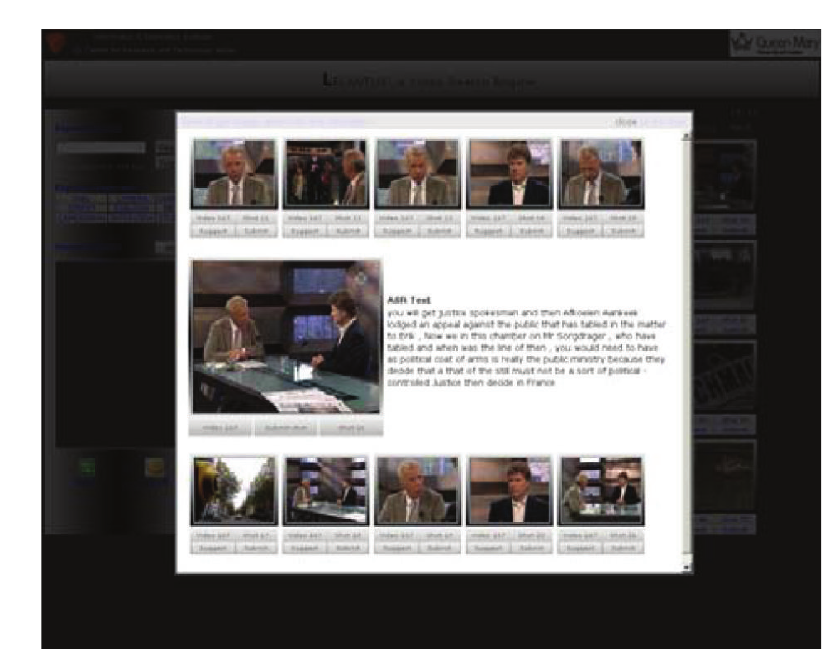
Figure 8: GUI showing the temporal neighboring shots and the associated ASR text of a